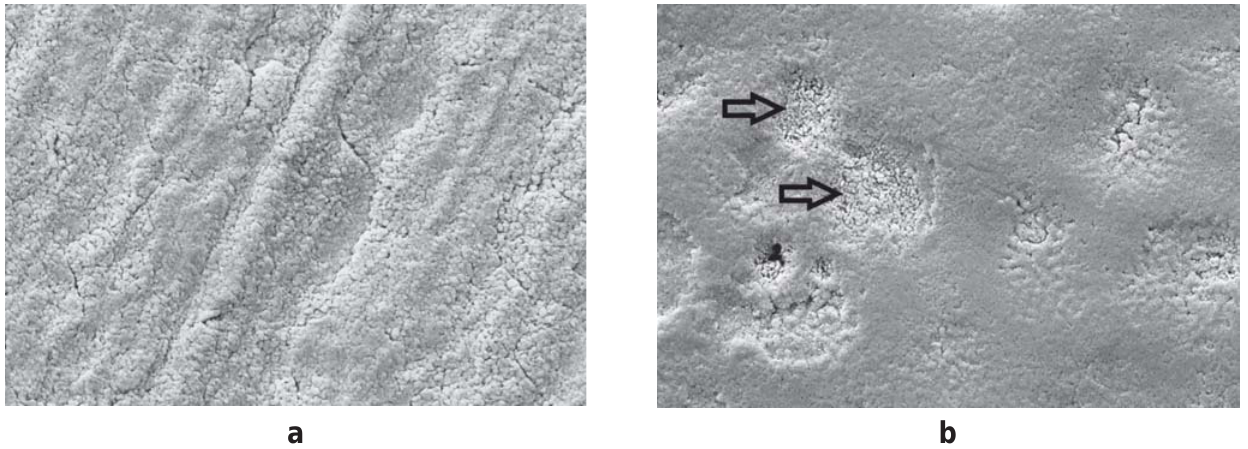
FIGURE 6- SEMs of ground (6a) and intact (6b) enamel surfaces treated with i-Bond self-etching adhesive. Enamel crystallites were exposed by adhesive application in grounded surfaces (6a) and shallow pits (arrows) were noted along the intact surfaces (6b) (x10,000)